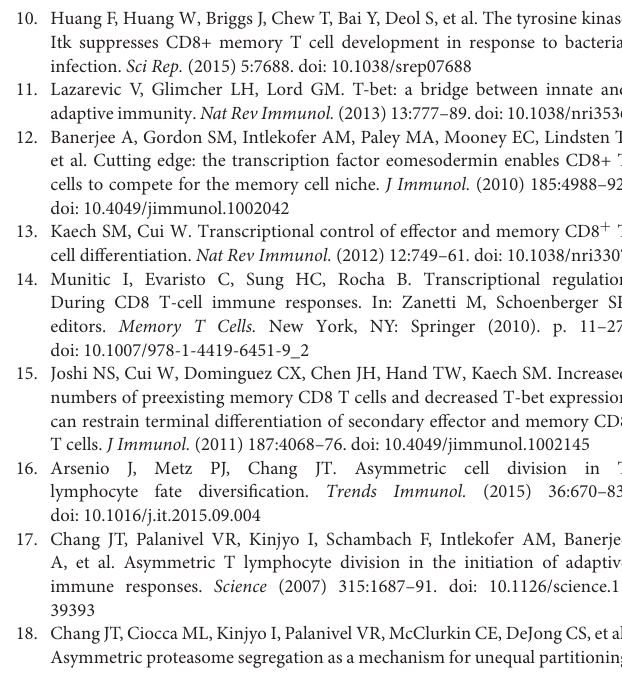
Supplementary File 1 | Parameter value tables and sensitivity analysis to parameter Eomes th . Supplementary File 2 | CompuCell3D simulation files used to generate the results presented in this